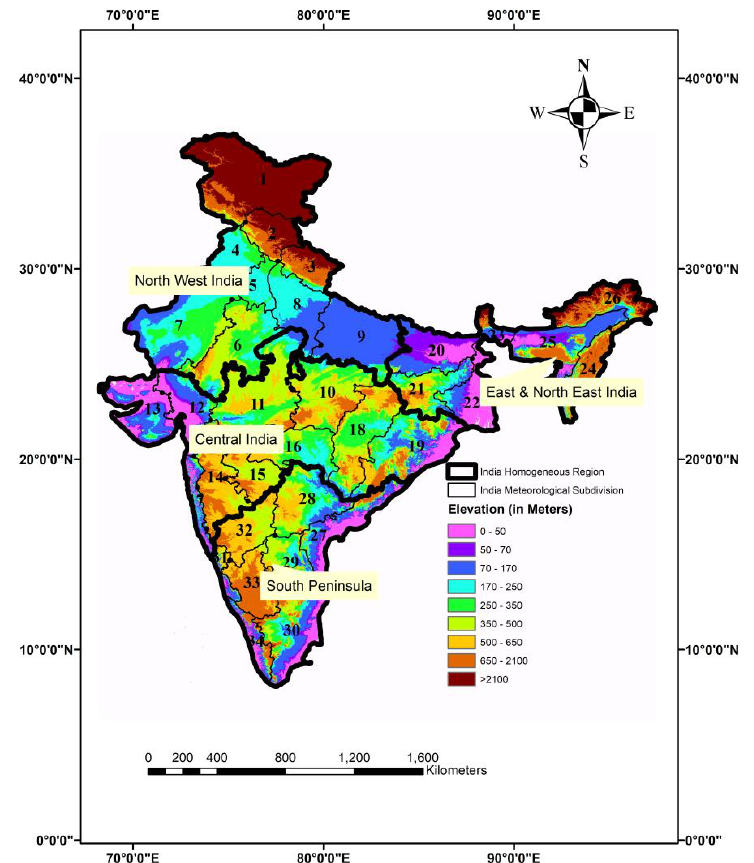
Figure 1. Map showing the study area and elevation information (in meters). Homogenous and Met subdivisions are Northwest India (Jammu and Kashmir (1), Himachal Pradesh (2), Uttarakhand (3), Punjab (4), Haryana (5), East Rajasthan (6), West Rajasthan (7), West UP (8), East UP (9)), Central India (East MP (10), West MP (11), Gujarat Region (12), Sourastra (13), Madhya Maharashtra (14), Marathwada (15), Vidarbha (16), Conkan and Goa (17), Chhattisgarh (18), Odisha (19)), East and Northeast India (Bihar (20), Jharkhand (21), Gangetic WB (22), SHWB (23), NMMT (24), Assam and Meghalaya (25), Arunachal Pradesh (26)), South Peninsula (Coastal AP (27), Telangana (28), Rayalaseema (29), Tamil Nadu (30), Coastal Karnataka (31), N.I. Karnataka (32), S.I. Karnataka (33), Kerala (34)).